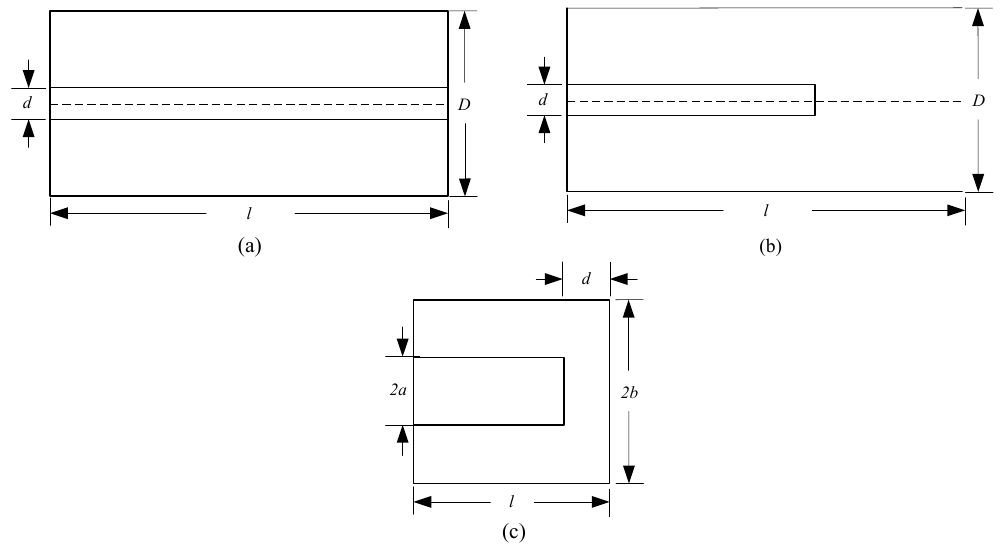
Figure 8. Scheme of the coaxial cavity: ( a ) λ /2, ( b ) λ /4 and ( c ) capacitive-loaded coaxial cavity.